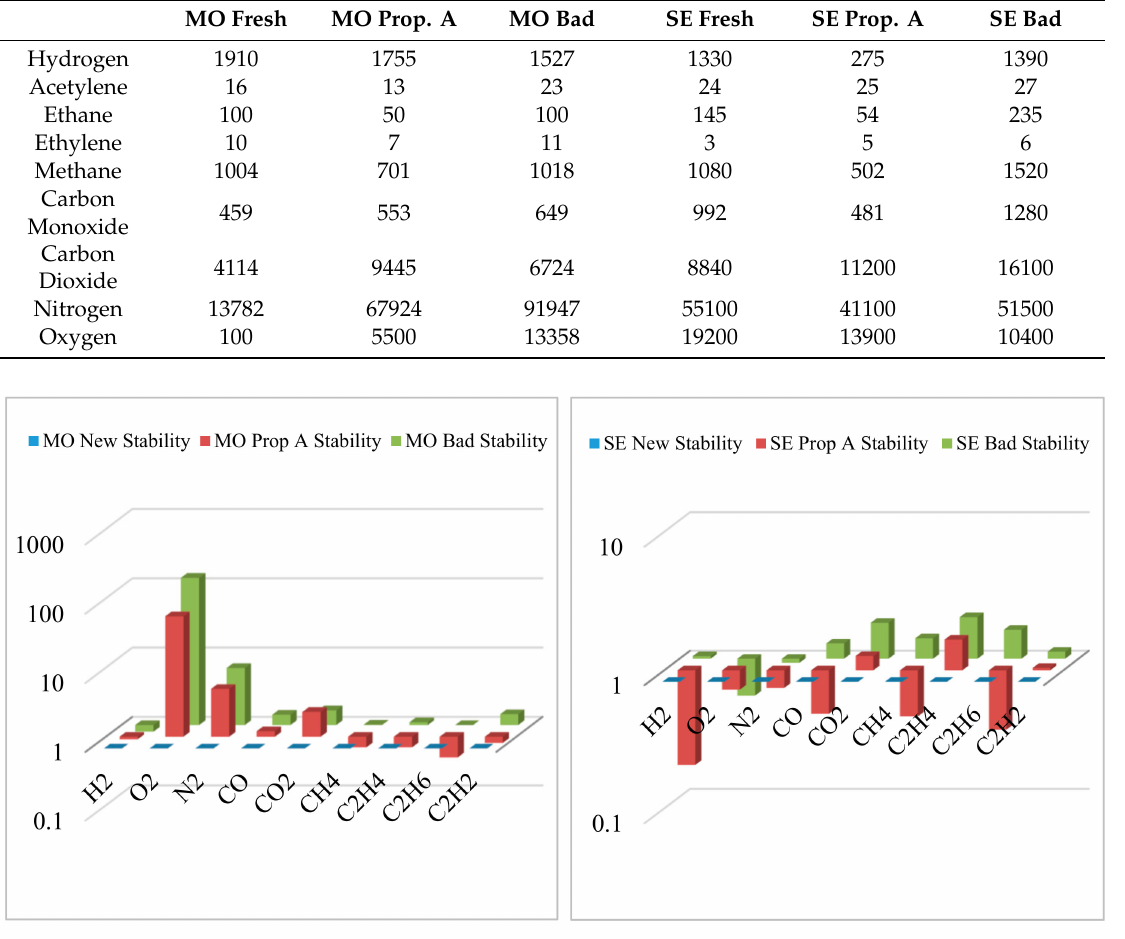
Table 2. Absolute values of the dissolved gasses in ppm.